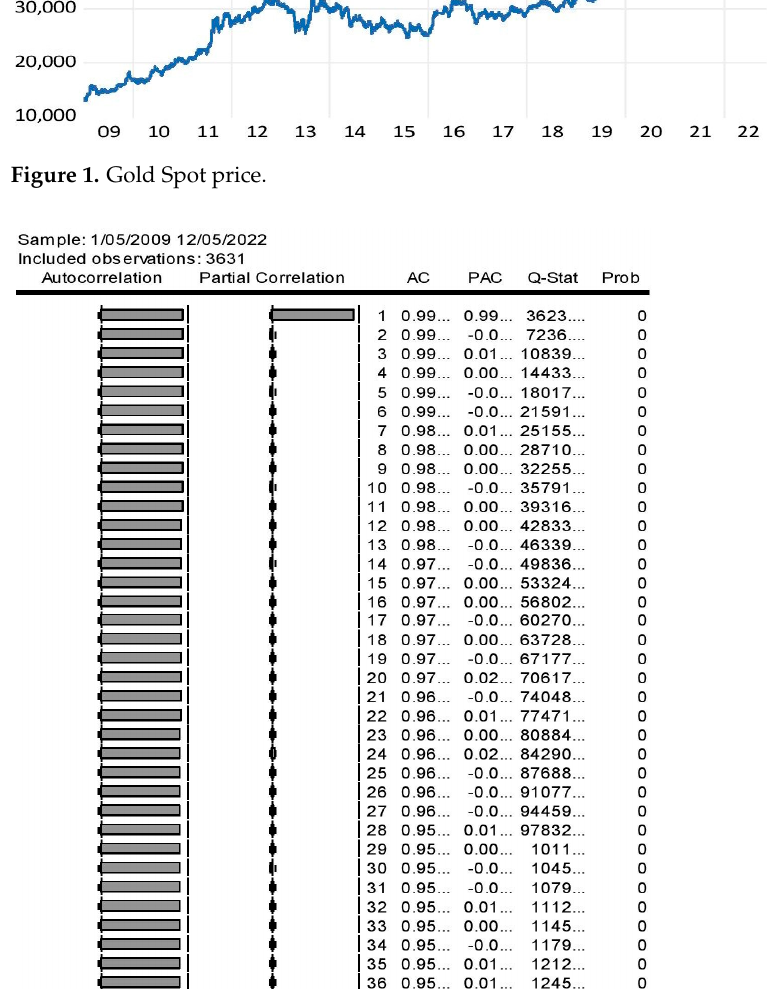
Figure 2. Correlogram Plot of Gold Price.